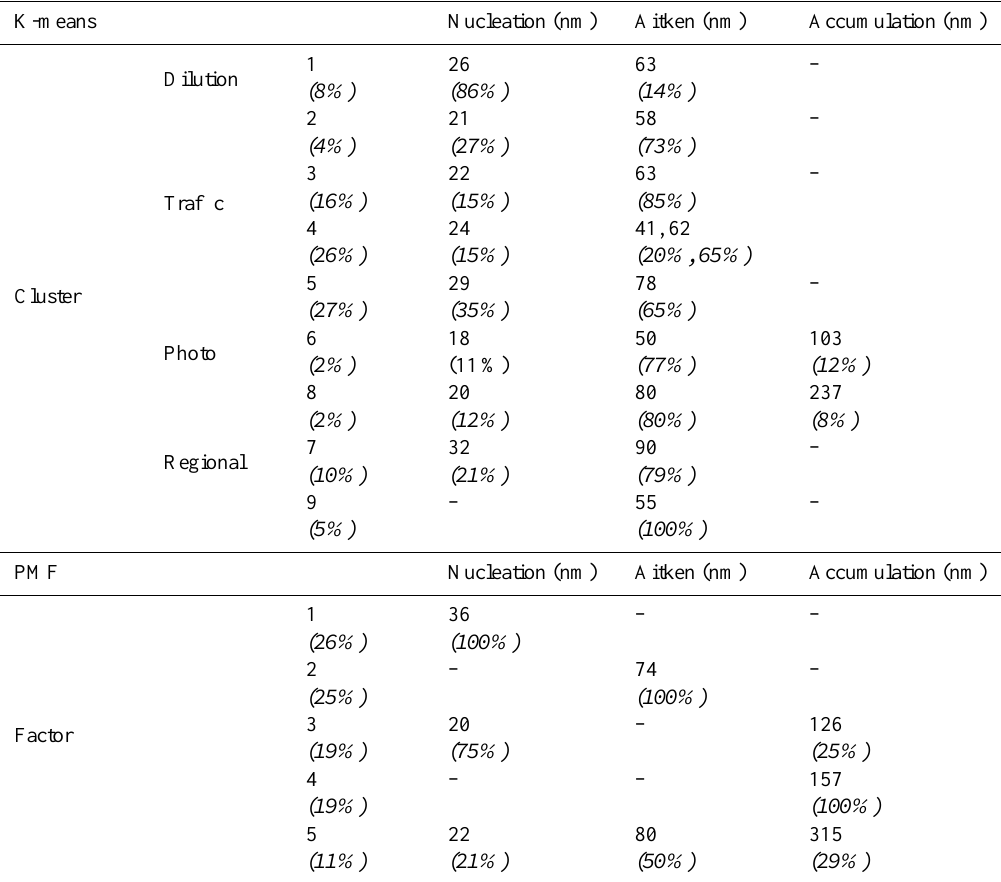
Table 4. Summary of the log normal fitting of K-means clustering and PMF analysis. When multi modality is found, relative contribution is given. Peak maximum values were found in the order of 18–36nm, 41–90nm and 103–315nm for the nucleation, Aitken and accumulation modes,